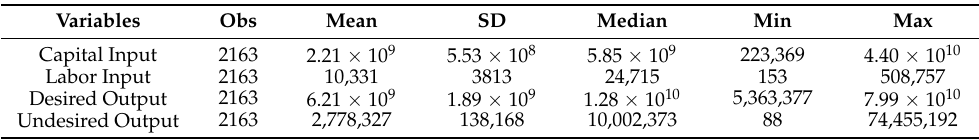
Table A2. Descriptive statistics of input and output.